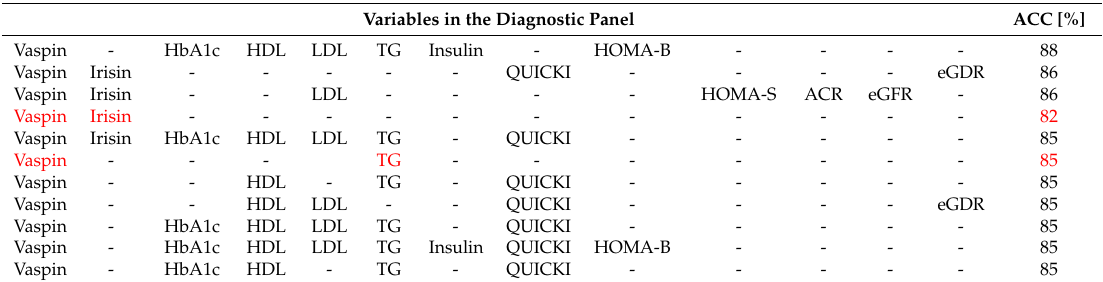
Table 5. Multiparameter discriminant analysis which allow to di ff erentiate the metabolic state of T2DM obese patients before and after metformin treatment. Variables in the Diagnostic